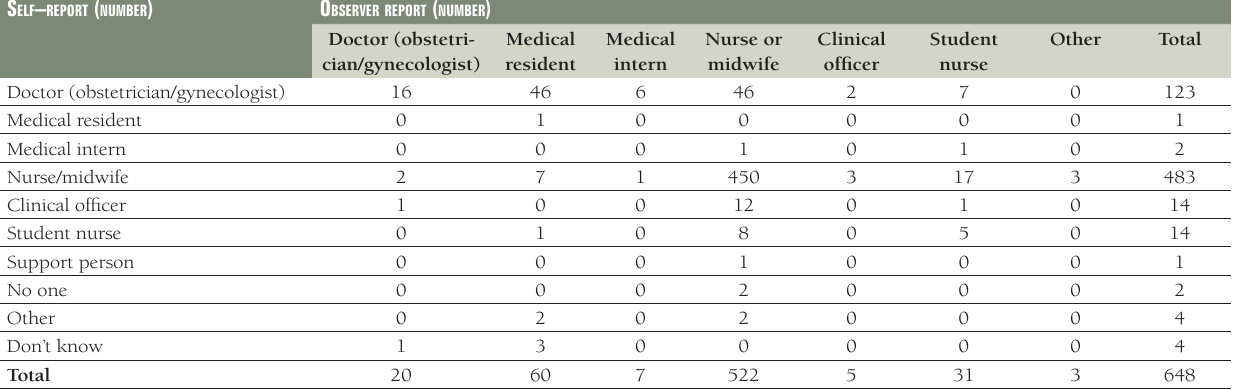
Table 5. Cross–tabulation of main provider during delivery based on observer reports and women’s responses s elf – report ( Number )